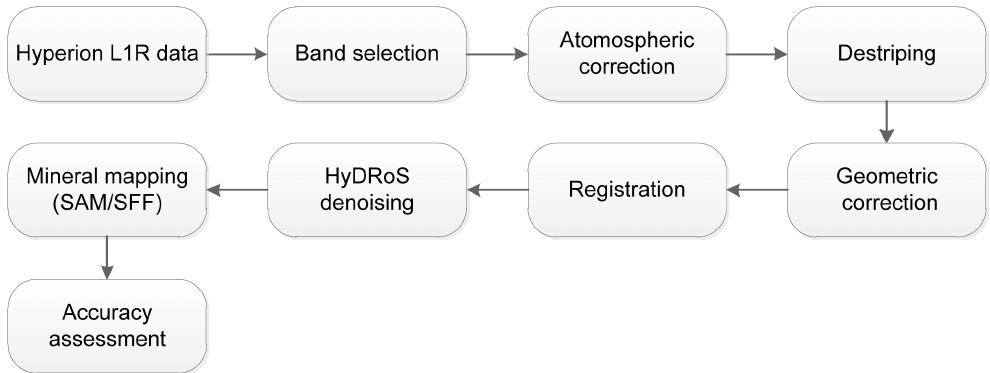
Figure 11. Flowchart of the real data experiment using Hyperion Level 1R